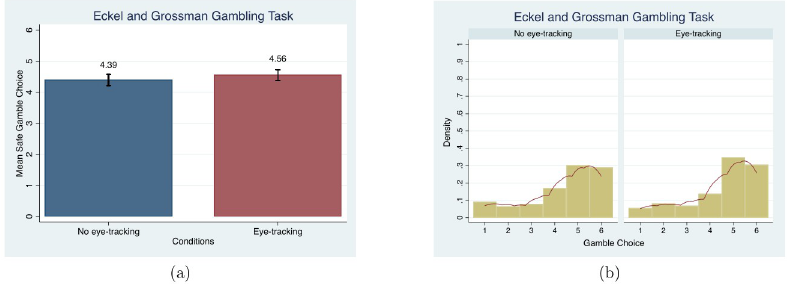
Fig 6. Mean and distribution comparisons in the gamble choices. Note. Red lines in (b) present the univariate kernel density estimation.